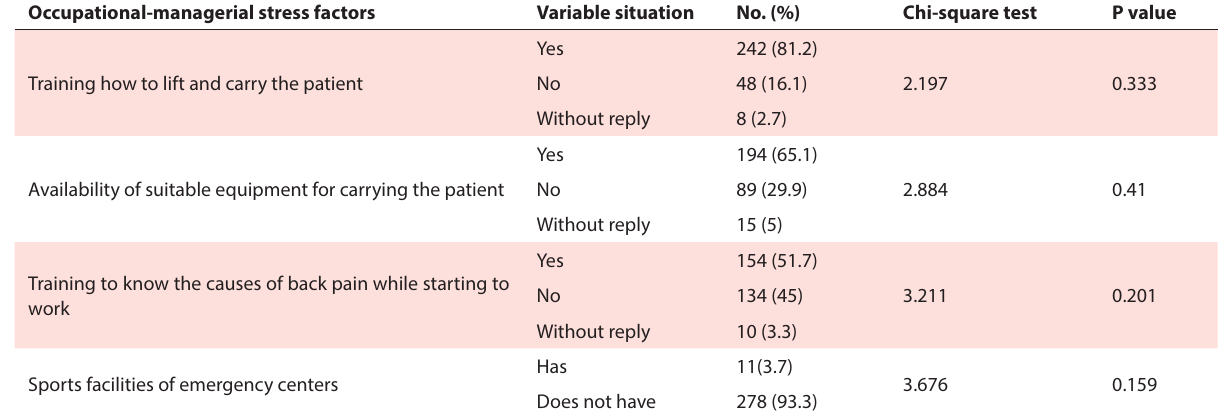
Table 4. Frequency distribution of occupational-managerial stress factors in the pre-hospital emergency personnel and its relationship with low back